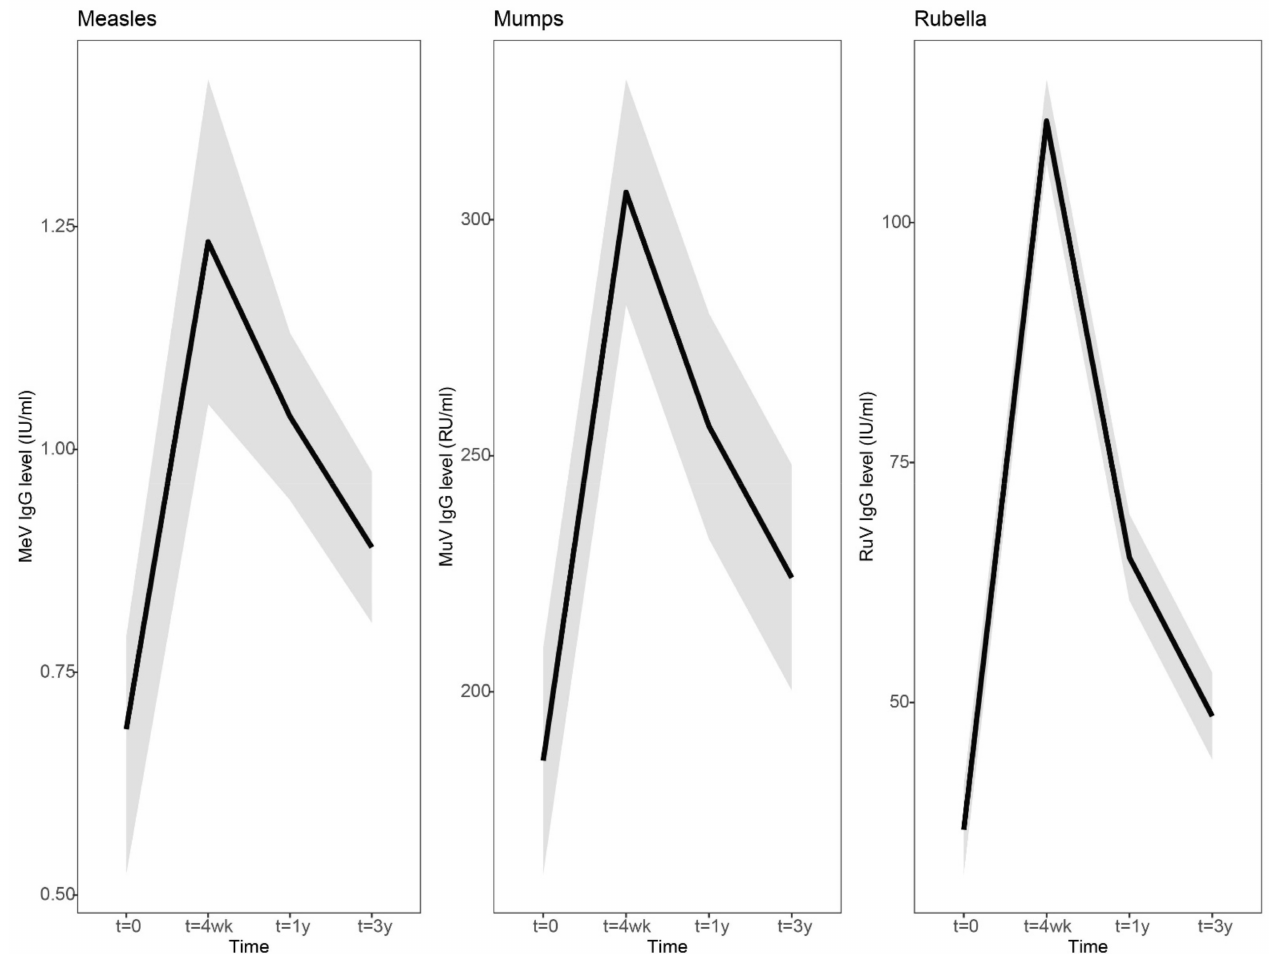
Figure 2. Dynamic course of IgG antibody responses to measles, mumps and rubella virus after a third measles-mumps-rubella vaccine dose. A linear mixed model was used to compare the dynamic IgG antibody response to measles (left), mumps (middle), and rubella (right) prior to, and 4 weeks, 1 year and 3 years following an MMR3 dose. Fitted averaged dynamic course of antibody levels, based on the results of the model fit, are presented as bold lines. Abbreviations: MeV-IgG, measles virus-specific IgG concentration; MuV-IgG, mumps virus-specific IgG concentration; RuV-IgG, rubella virus-specific IgG concentration; RU/mL, RIVM units per milliliter; IU/mL, international units per milliliter; t = 4 wk, four weeks after a third dose of measles-mumps-rubella vaccine dose (MMR3); t = 1 y and t = 3y, resp. 1 year and 3 years after an MMR3